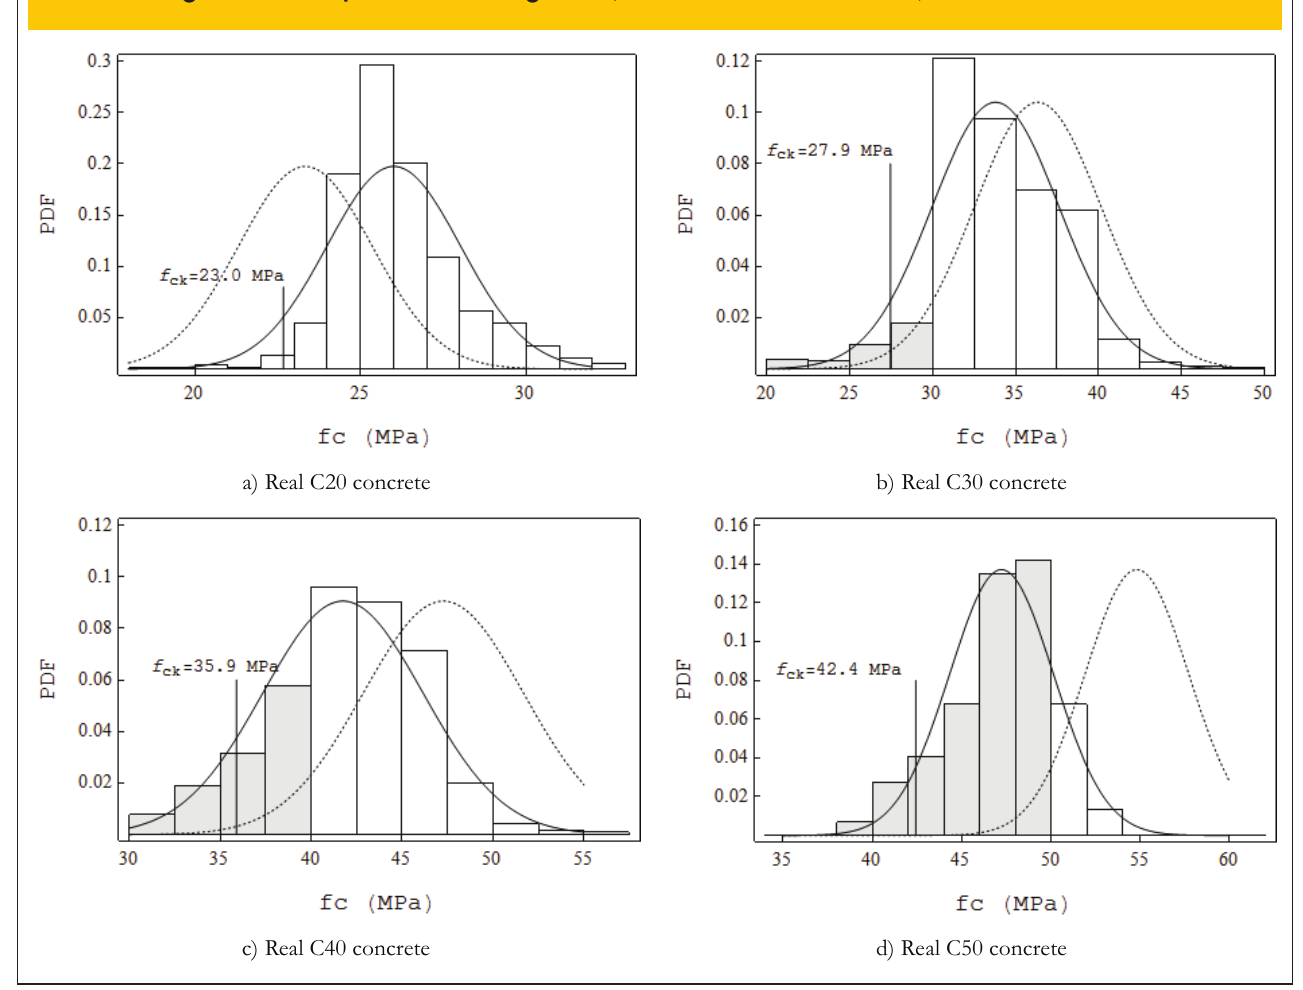
Figure 2 – Comparison of histograms (and distribution functions) for real